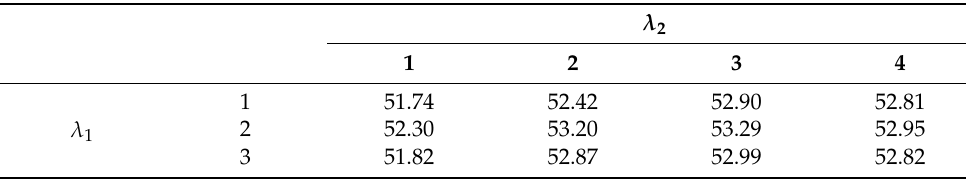
Table 3. Testing loss function weights for generating pseudo masks in PASCAL VOC 2012 training set in MIOU (%).